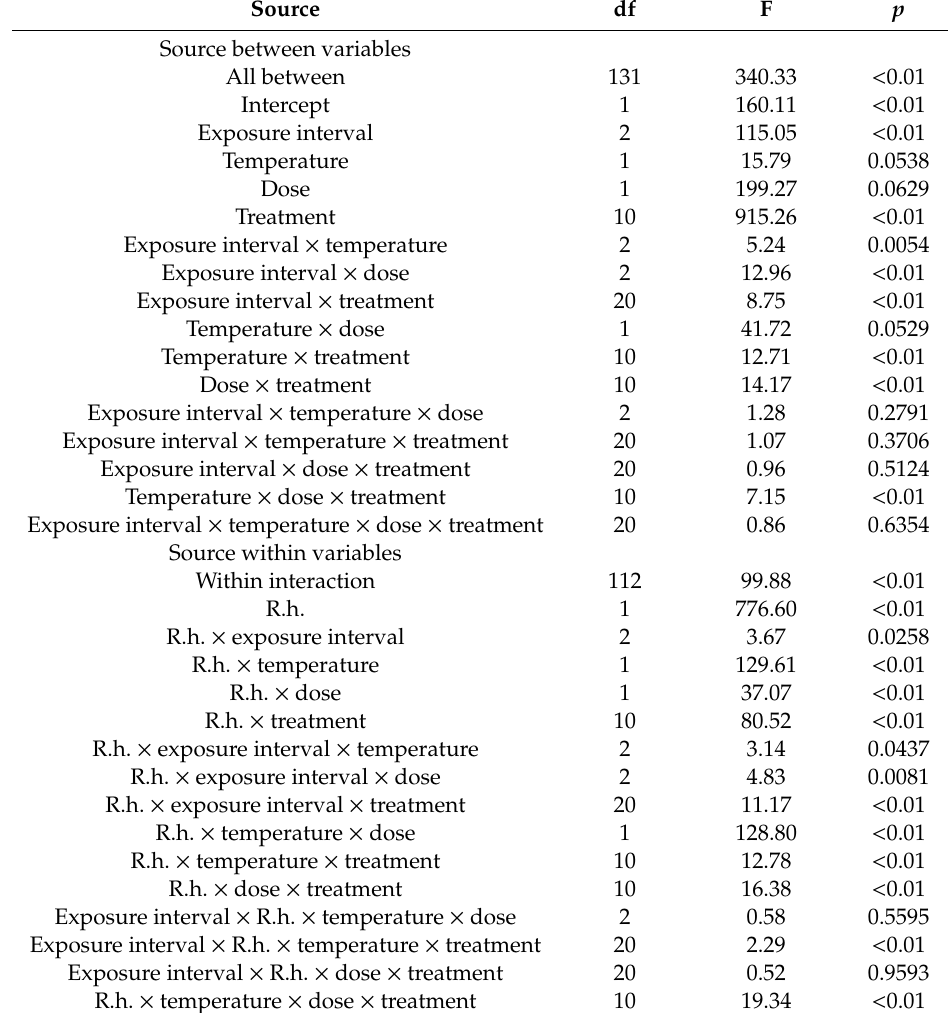
Table 4. Repeated measures ANOVA (analysis of variance) parameters for the main e ff ects and associated interactions for the mortality level of rice weevil adults (error df =